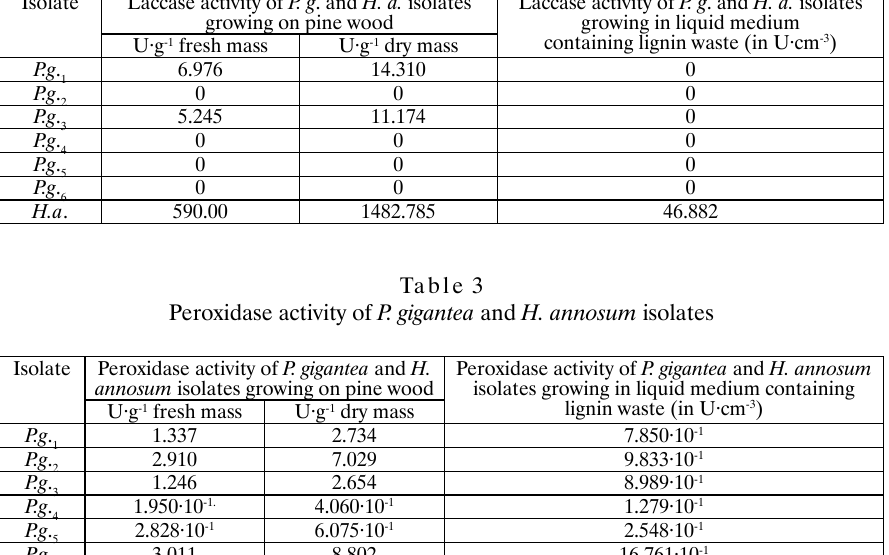
Laccase activity of P. gigantea and H. annosum isolates Isolate Laccase activity of P. g . and H. a. isolates Laccase activity of P. g . and H. a. isolates growing on pine wood growing in liquid medium